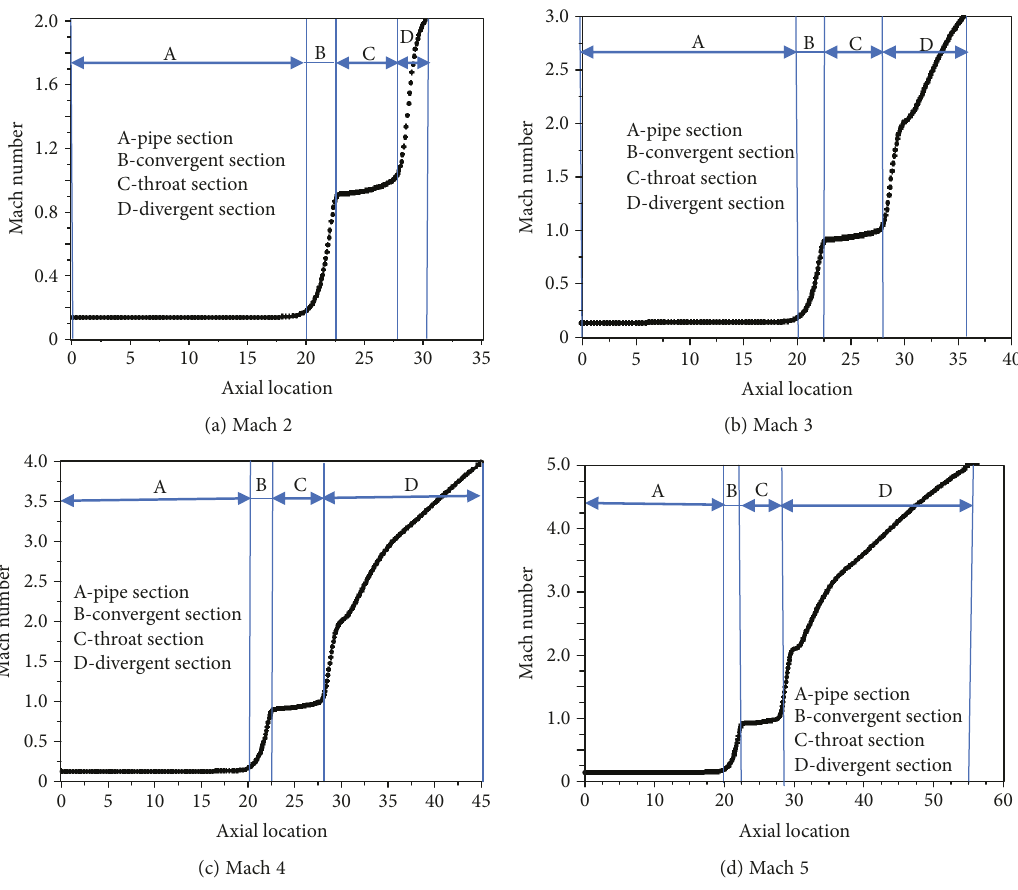
Figure 4: Mach number of the gas jets at nozzle exits.